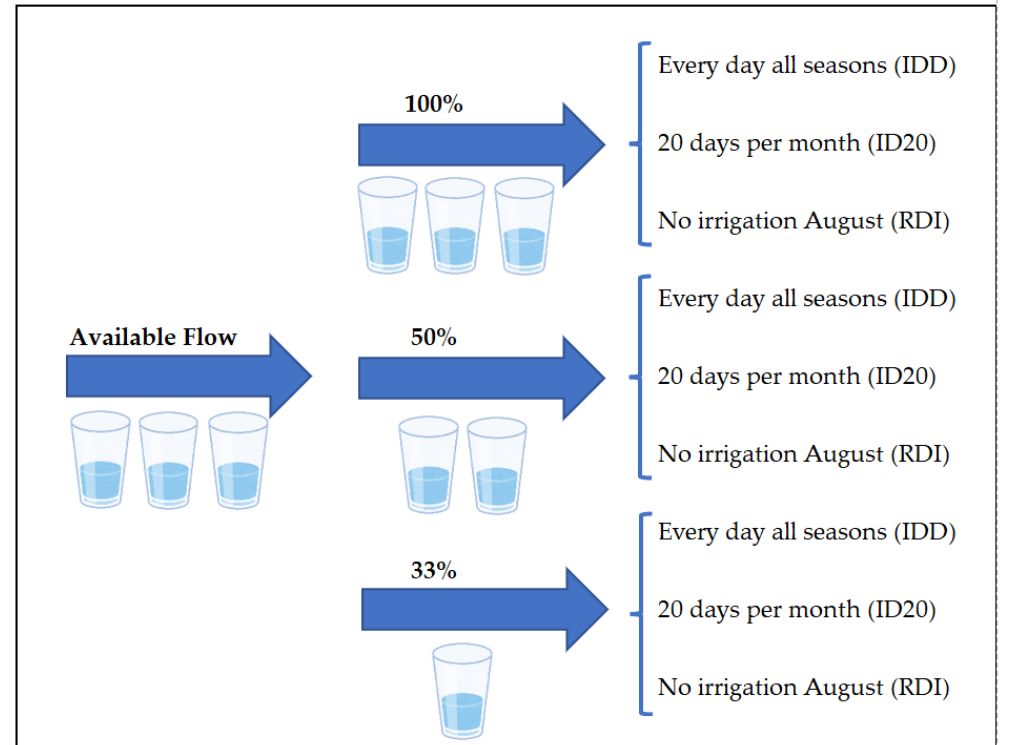
Figure 4. Summary of the irrigation scenarios considered in the modeling. These scenarios were also evaluated in three different climatic conditions.